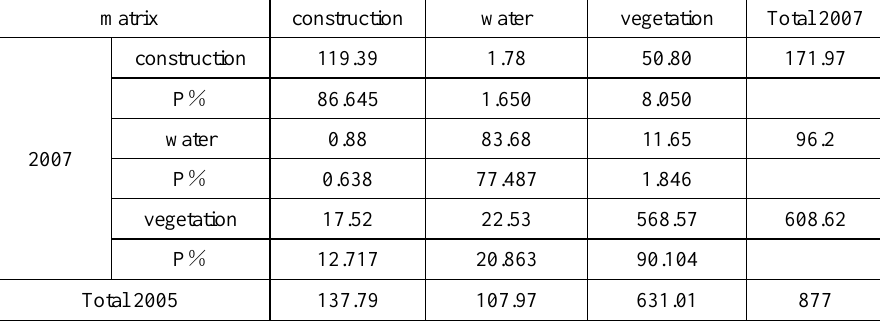
Table3. The land-use transformation matrix of study area from 2005 to 2007